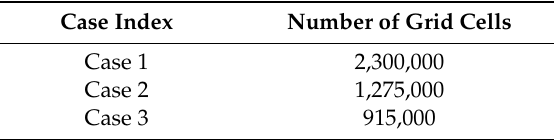
Table 3. The number of grid cells.